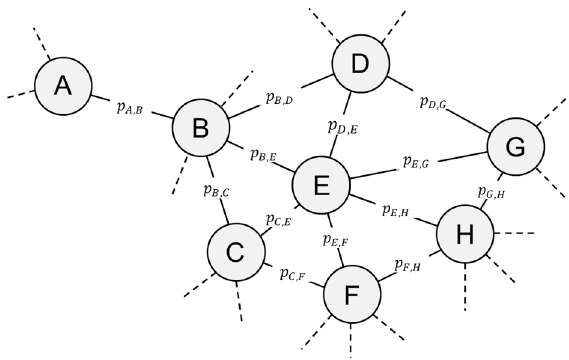
Figure A4. Exemplary subset of the technology space.